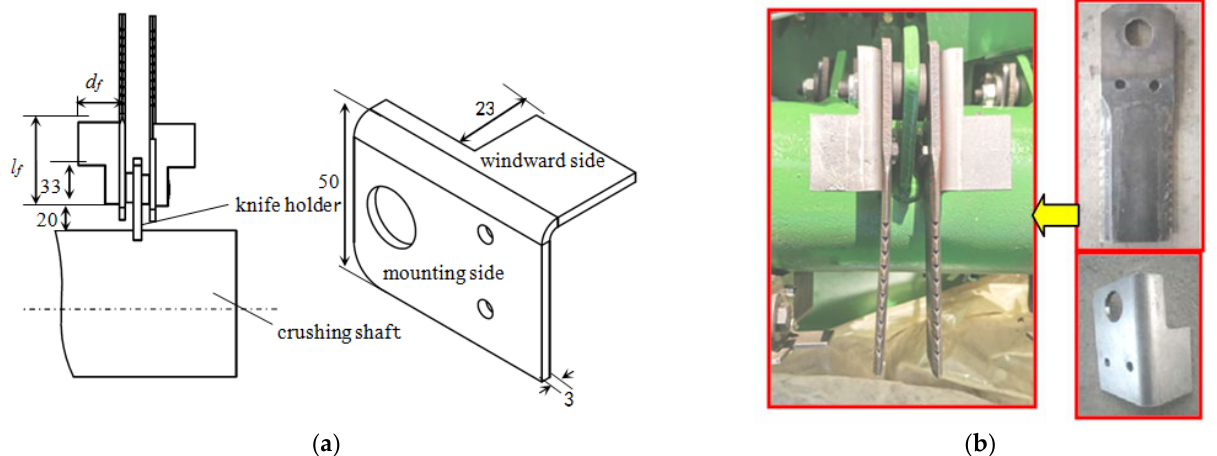
Figure 2. WB structure and physical pictures. ( a ) WB structure; ( b ) WB installation. l f is the length of the windward side, mm; d f is the width of the windward side, mm.